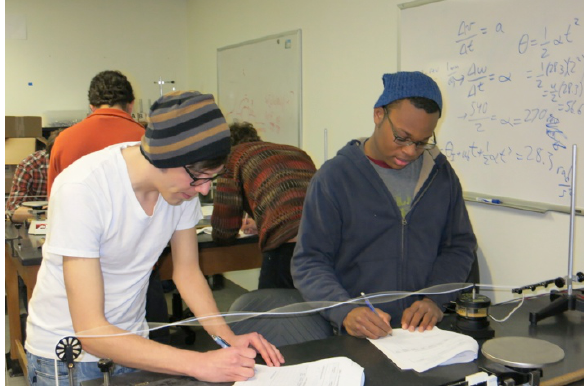
Figure 2. Student teams investigating standing waves on a string.